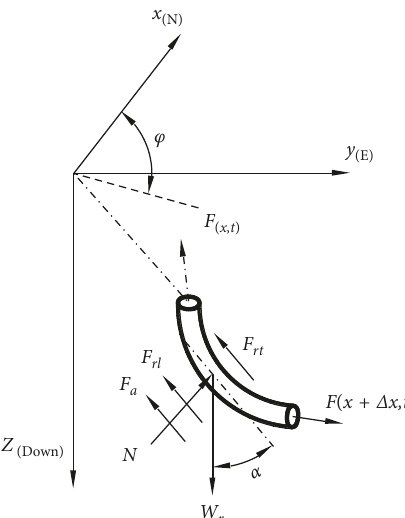
Figure 4: Force schematic diagram of the sucker rod microunit.